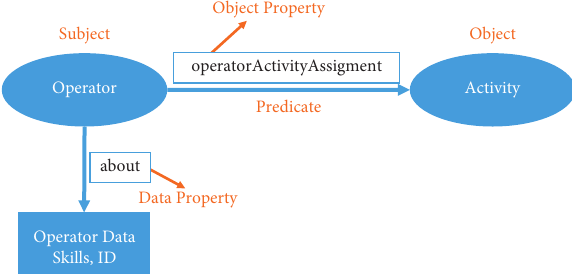
Figure 7: Theoretical example of an RDF triple in an RDF